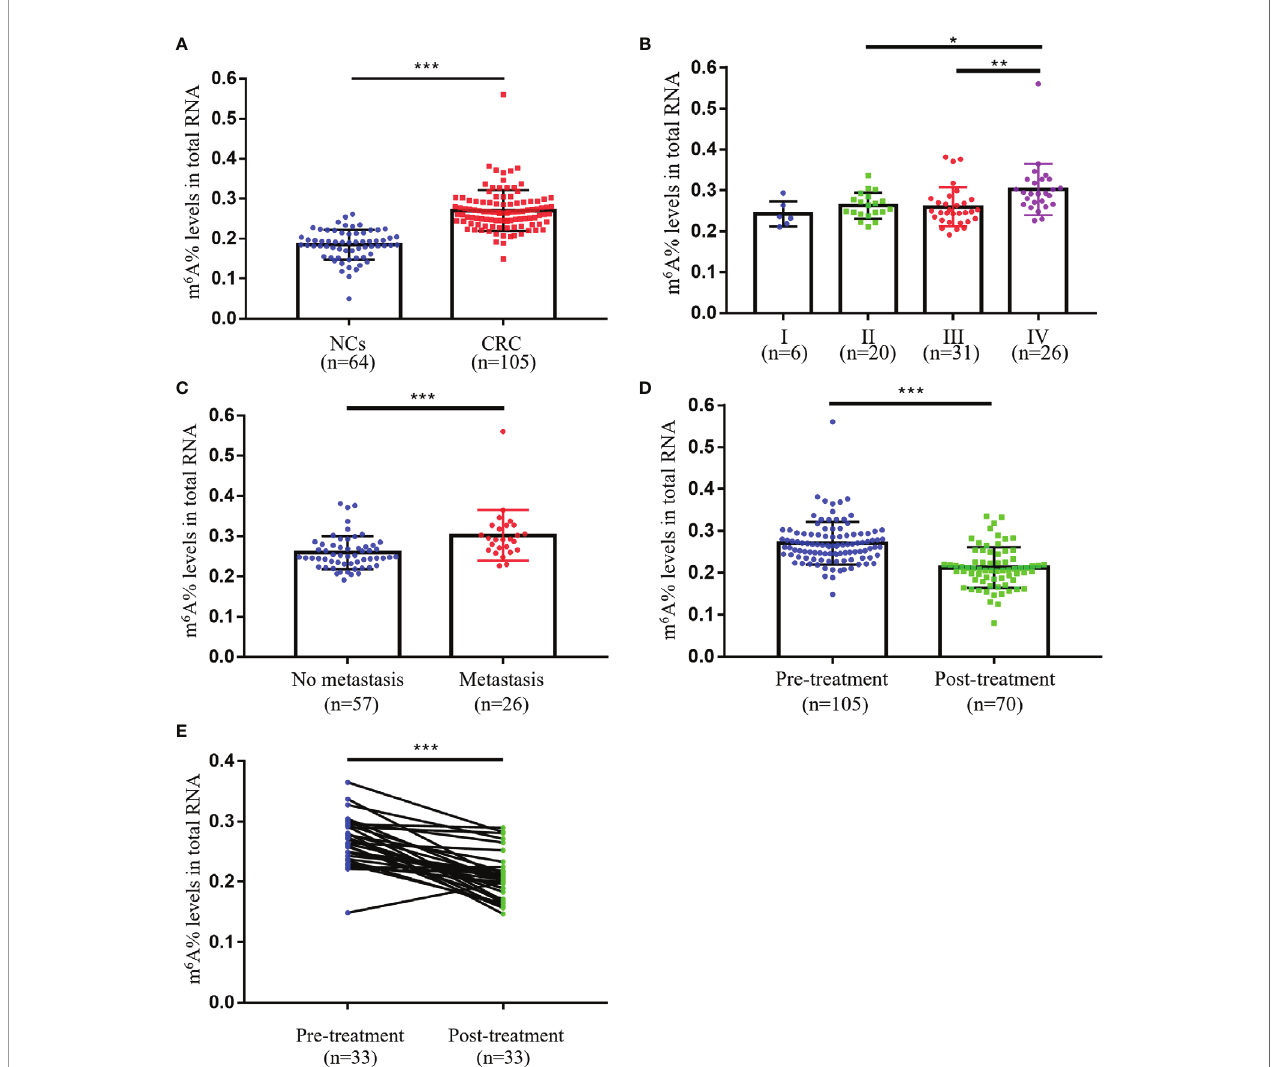
FIGURE 1 | The m 6 A RNA levels of peripheral blood immune cells in CRC patients and NCs. (A) The m 6 A levels of peripheral blood RNA in NCs ( n = 64) and CRC patients ( n = 105). (B) The m 6 A levels of peripheral blood RNA at different clinical stages of CRC patients (stage I, n = 6; stage II, n = 20; stage III, n = 31; stage IV, n = 26). (C) Comparison of m 6 A levels of peripheral blood RNA between CRC patients with ( n = 26) and without ( n = 57) metastasis. (D) Comparison of m 6 A levels of peripheral blood RNA between CRC patients with ( n = 70) and without ( n = 105) treatment. (E) The m 6 A levels of peripheral blood RNA in CRC patients ( n = 33) before and after 14 days of treatment. Bars represent the mean ± SD of the results from replicate measurements; * p < 0.05, ** p < 0.01 and *** p <